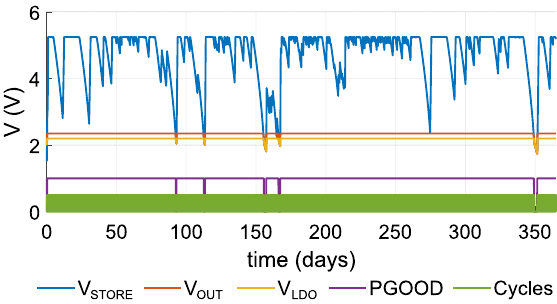
Figure 18. Graph of voltage levels; case I SLEEP = 1.65 µ A, T = 4